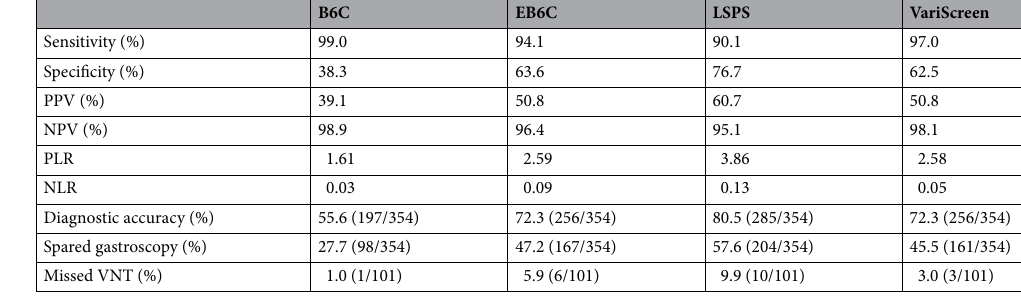
Table 3. Performance and safety of the NITs in patients with cACLD. NITs, non-invasive tests; cACLD, compensated advanced chronic liver disease; B6C, Baveno VI criteria; EB6C, Expanded Baveno VI criteria; LSPS, liver stiffness-spleen diameter to platelet ratio risk score; PPV, Positive Predictive Value; NPV, Negative Predictive Value; PLR, Positive Likelihood Ratio; NLR, Negative Likelihood Ratio; VNT, varices needing treatment.